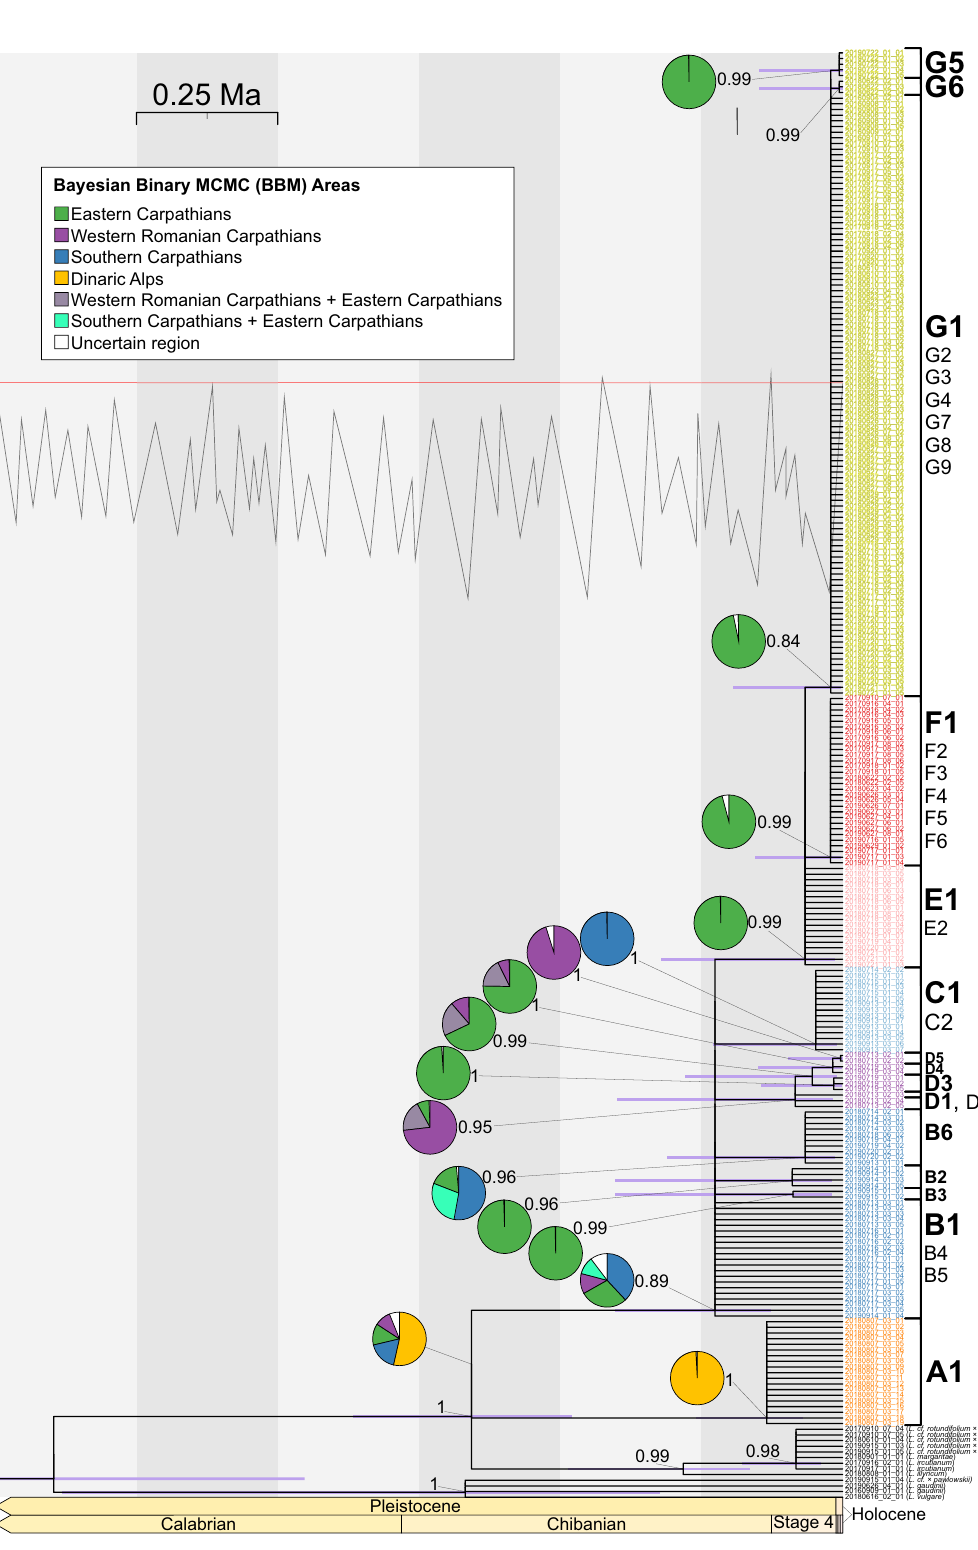
Figure 3. Phylogenetic tree constructed with three intergenic spacer regions in cpDNA ( psb A -trn H, ndh C ret-trn V - comp, and trn T(GGU) - comp -psb D - comp). The numbers associated with the nodes indicate posterior probabilities from Bayesian analysis. Bars represent uncertainty of dating for a particular node. Pie charts represent the most plausible ancestral locations inferred by Bayesian binary Markov Chain Monte Carlo method (BBM) and are shown only for nodes associated with the focal species. The L. rotundifolium samples are colored according to the results of the phylogenetic analysis of the clustering algorithm (Fig. 4). The tree includes all sympatric species of L. rotundifolium ( L. vulgare 2 x , L. gaudinii 2 x , L. ircutianum 4 x , L. margaritae 6 x , and L. illyricum 6 x ). The line in the upper part of the image represents changes in global temperature in the past. The horizontal red line indicates modern thermal conditions, while the peaks indicate higher temperatures and the troughs lower temperatures. The original figure was created by Robert A. Rohde, based on Lisiecki and Raymo (2005), and is available at https:// commo ns. wikim edia. org/ wiki/ File: Five_ Myr_ Clima te_ Change.